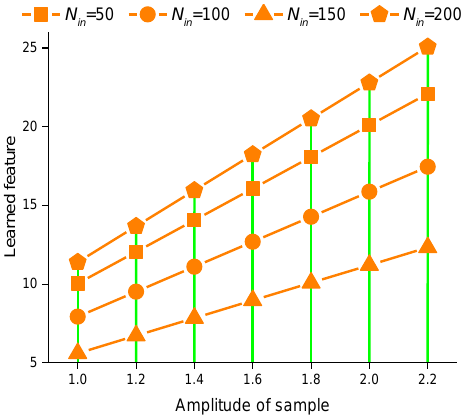
Figure 3. Relationship between the amplitudes of samples and the learned features.